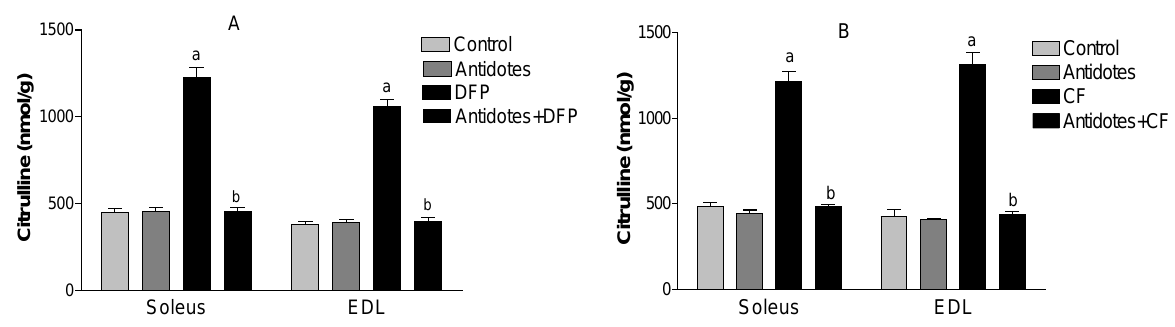
FIGURE 9. Effects of antidotes (MEM, 18 mg/kg, s.c. and ATS, 16 mg/kg, s.c.), given prophylactically 60 and 15 min, respectively, before (A) DFP or (B) CF administration on citrulline levels in skeletal muscles soleus and EDL of rats. Rats were sacrificed 60 min after DFP or CF injection. Values of citrulline are presented as mean ± SEM (n = 4). a Significant difference between values from control rats and DFP- or CF- treated rats ( p < 0.05). b Significant difference between values from DFP- or CF-treated rats and Antidotes+DFP– or Antidotes+CF–treated rats ( p < 0.05).